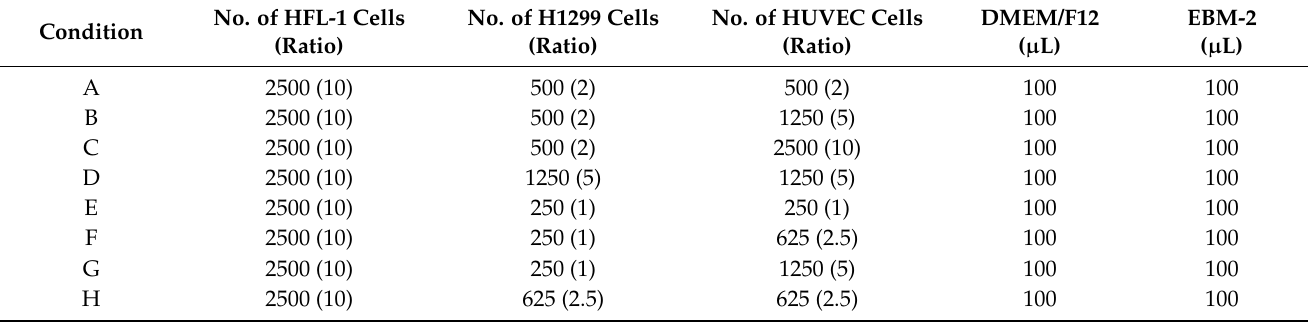
Table 2. Experimental design to find the optimal starting point for the lung co-culture